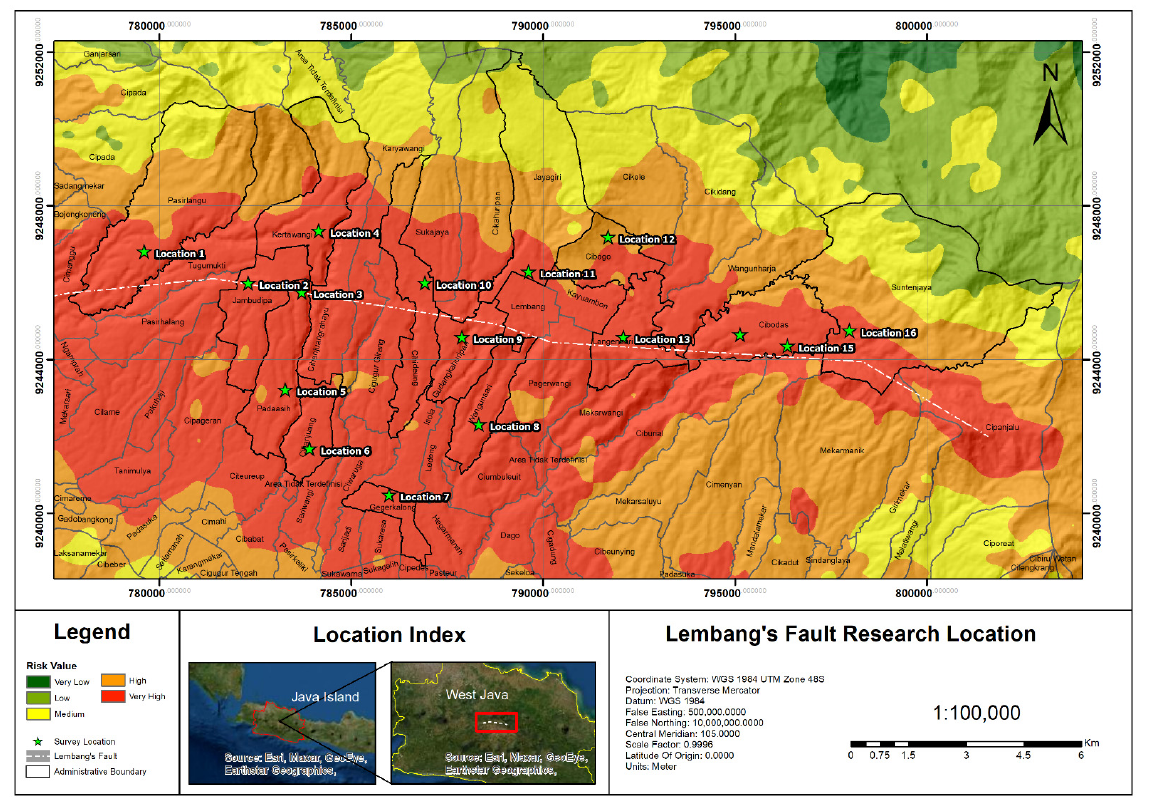
Figure 5. Location of survey in the Lembang Fault area. Table 1. Characteristics of the respondents.